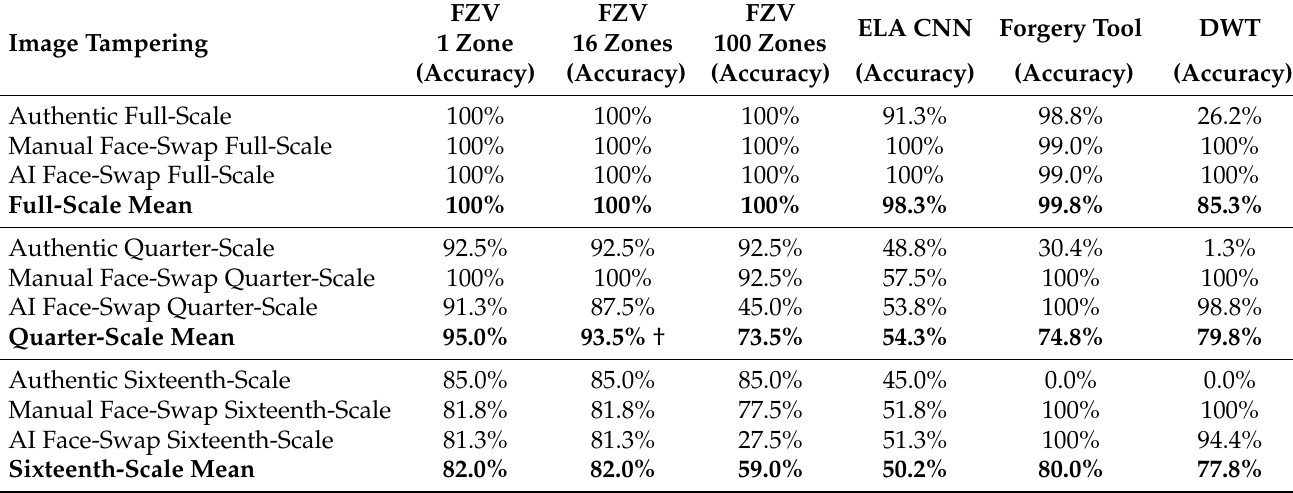
Table 1. Face-swap-attack verification